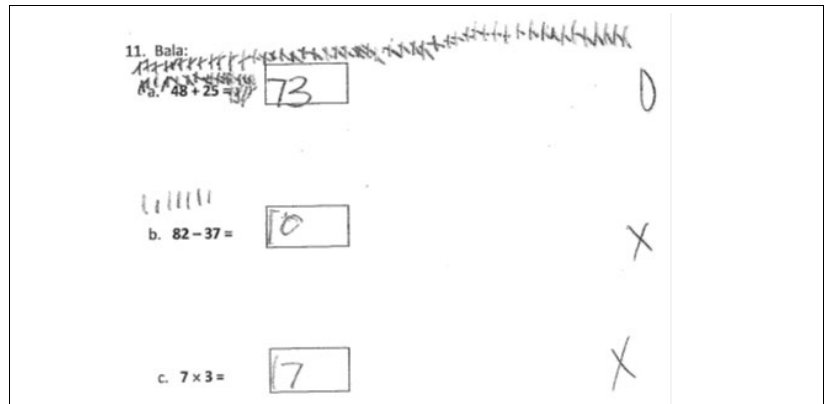
Figure 4: Extract 1 from grade 2 script, learner